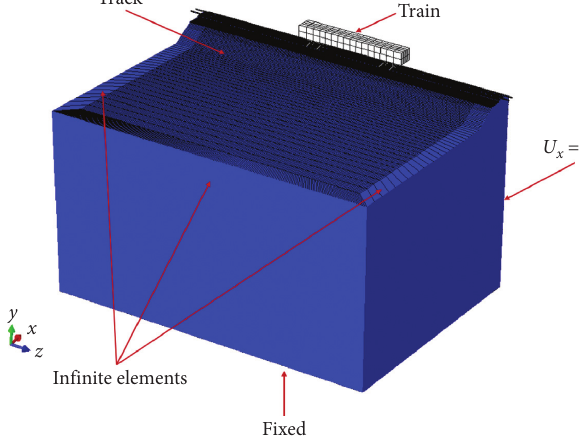
Figure 3: Symmetrical half model of the train-track-ground